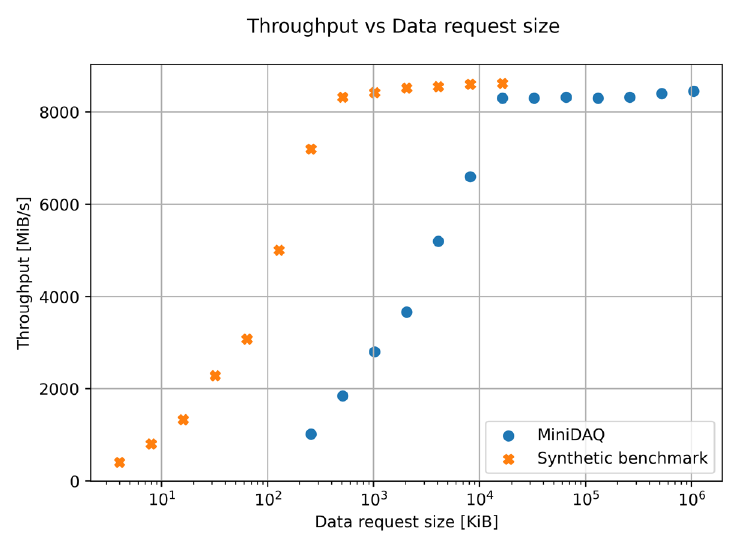
Figure 4. Comparison between the throughput achieved with a synthetic benchmark with 2 threads and with two MiniDAQ applications. The maximum bandwidth of the drive of approximately 8.5GiB / s is achieved in both